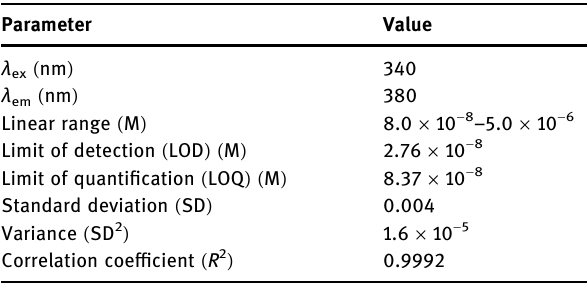
Table 1: Analytical characteristics of L with UO 22